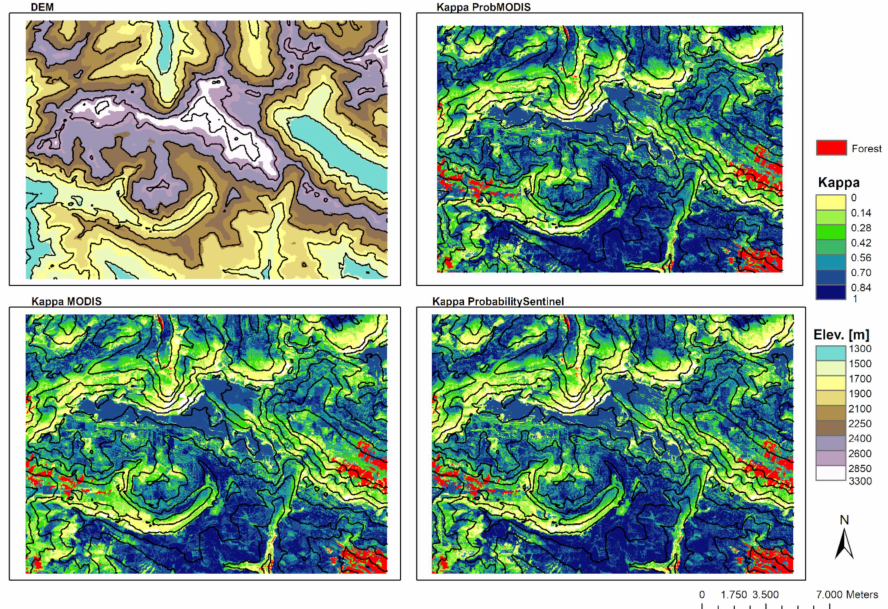
Figure 8. Spatial distribution of Kappa coefficients obtained in the Pyrenees for BinMODIS 20m imagery (bottom left panel), ProbMODIS (upper right panel) and ProbSentinel (bottom right panel) methods. In the upper left panel, the DEM of this test area is included for easier interpretation of the results. Forested areas are masked in